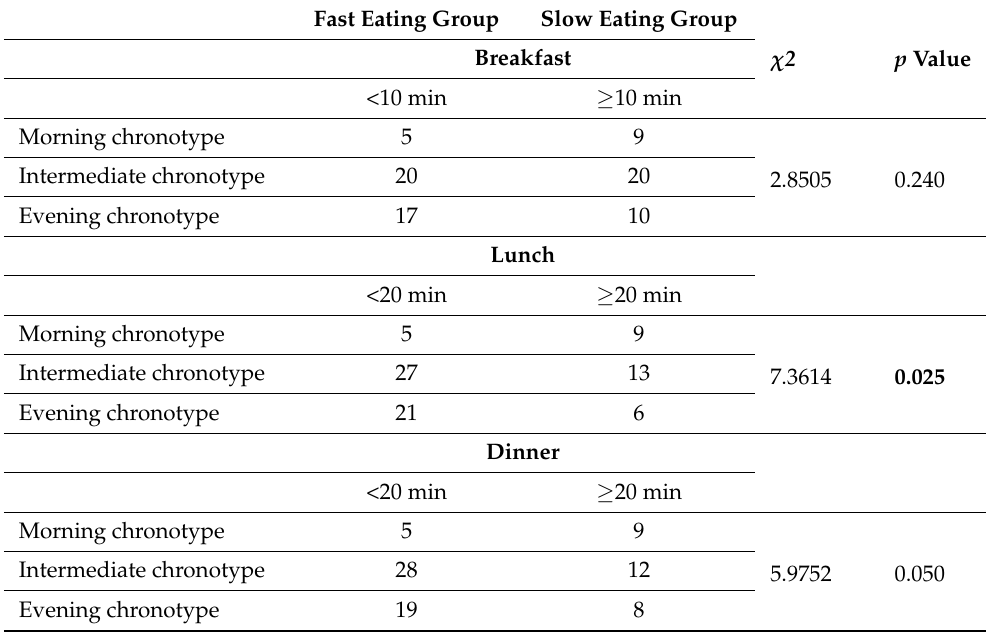
Table 3. Differences in chronotype categories according to eating speed during the three main meals. Fast Eating Group